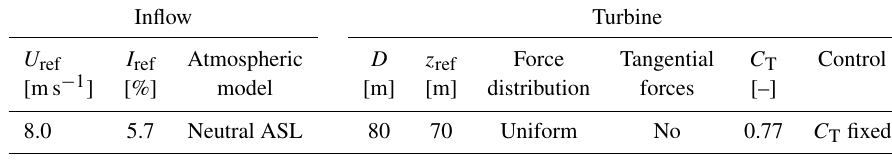
Table 6. Simulation parameters for the single-wake V80 case. Note that the LES uses neutral PDBL for the atmospheric model.